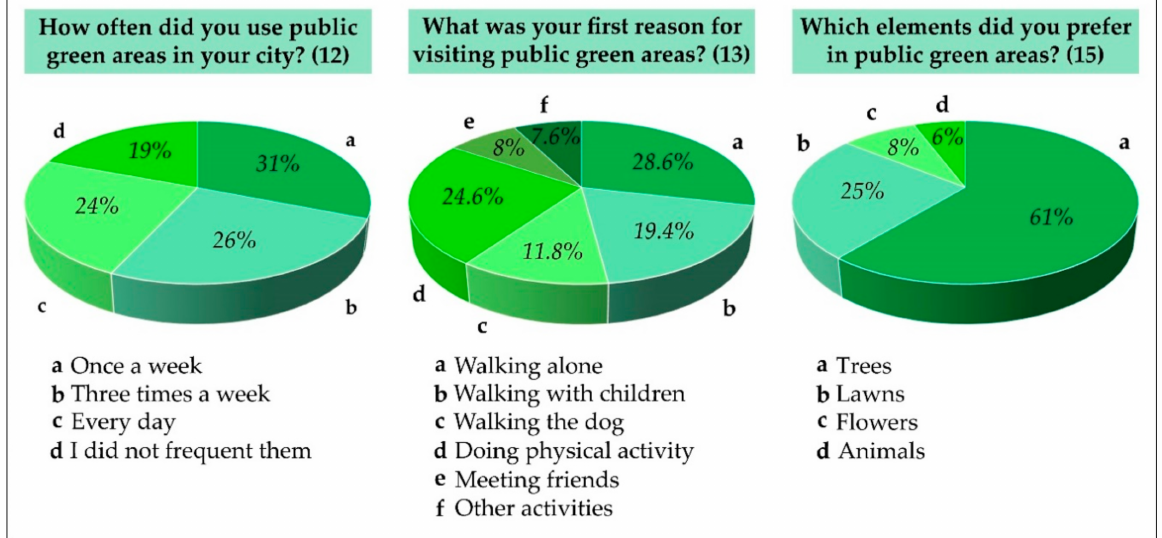
Figure 2. Habits and preferences about the use of public green areas before the social distancing period (questions 12, 13, and